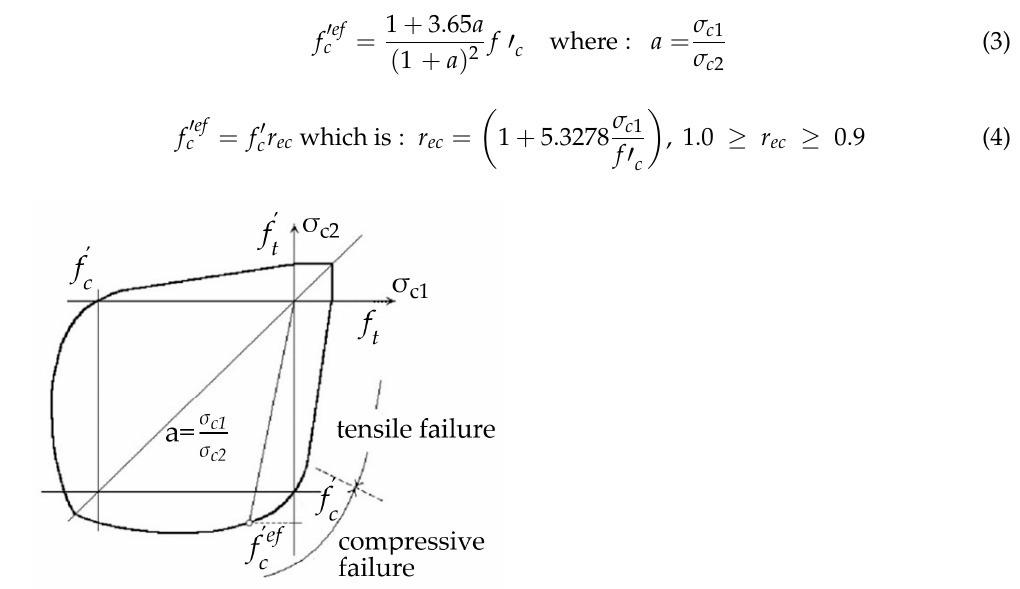
Figure 3. Biaxial failure function for concrete [18].